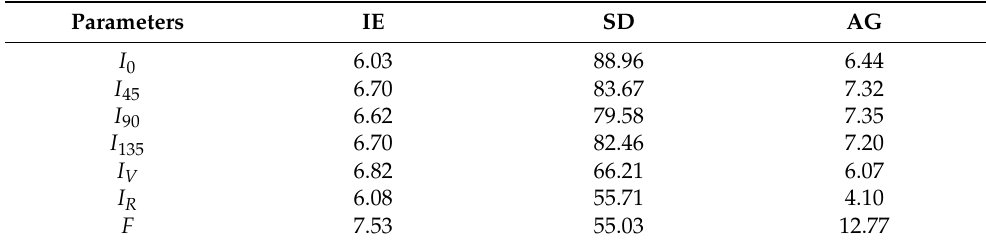
Table 4. List of various indicators of the fusion image.